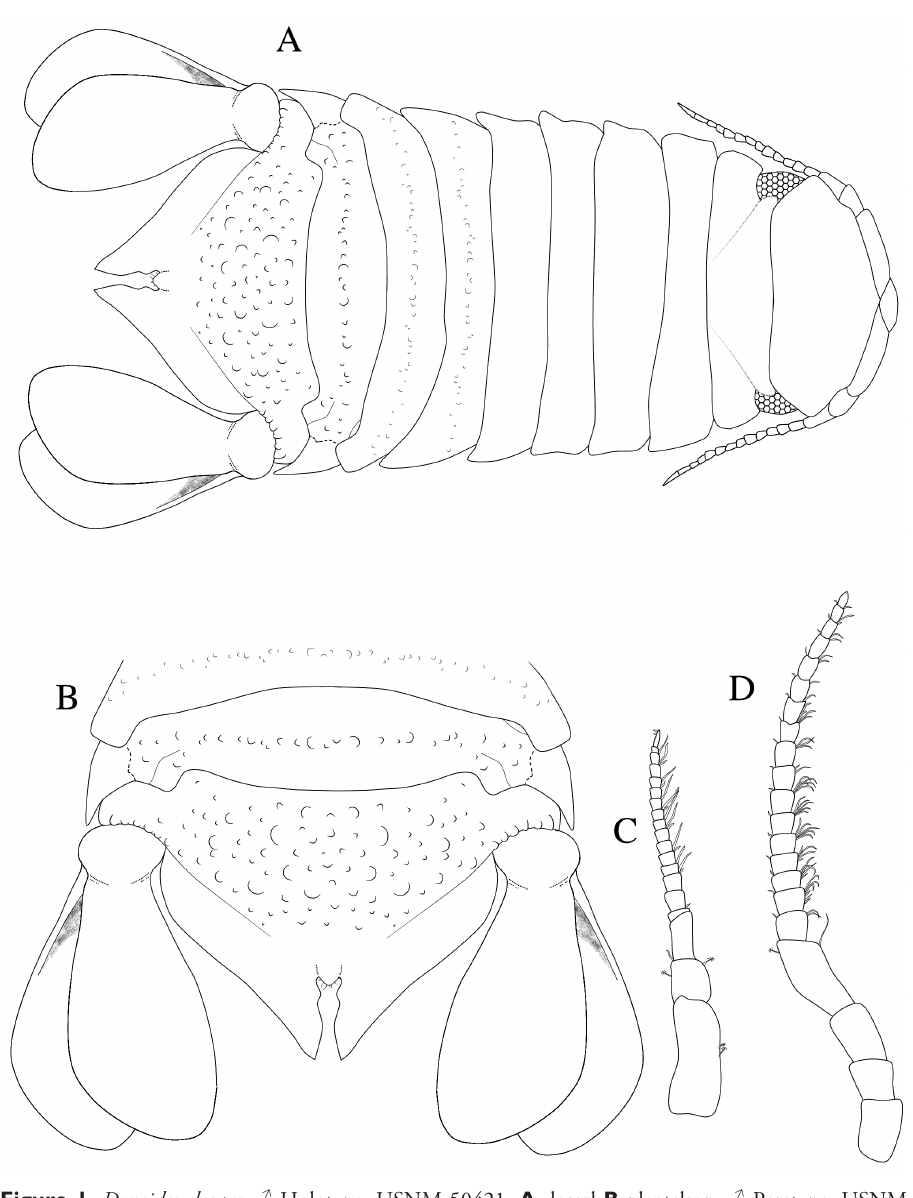
Figure 1. Dynoides elegans. ♂ Holotype. USNM 50421. A dorsal B pleotelson. ♂ Paratype. USNM 1422085. All from left C antennula D